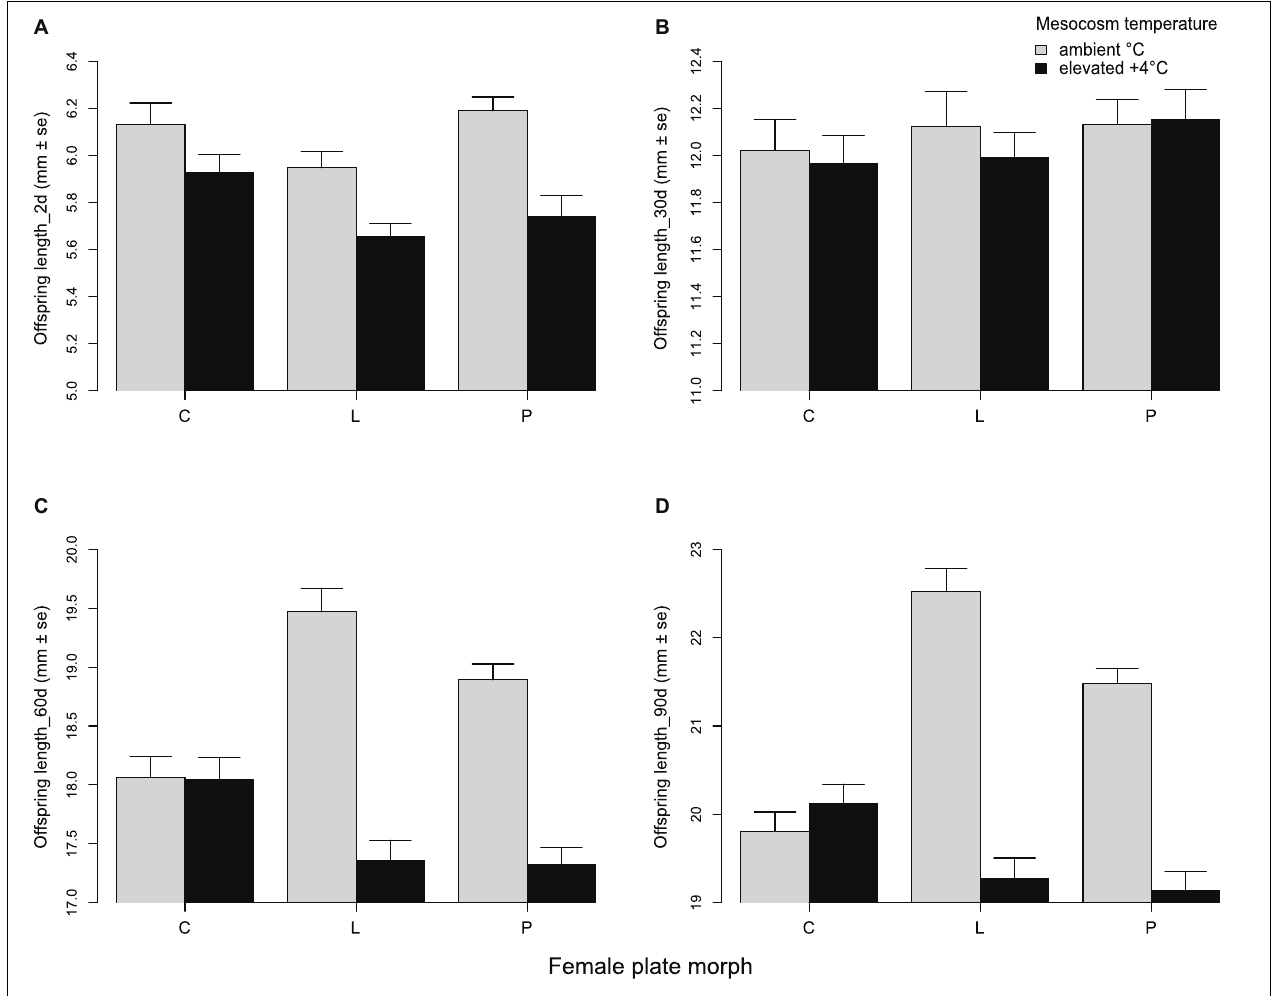
FIGURE 5 | Mean length (mm ± SE) of stickleback offspring depending on maternal plate morph (C, complete; L, low; P, partial) and environmental (mesocosm) temperature (ambient or +4 ◦ C): (A) 2 days post-hatch, (B) 30 days post-hatch, (C) 60 days post-hatch, and (D) 90 days post-hatch.